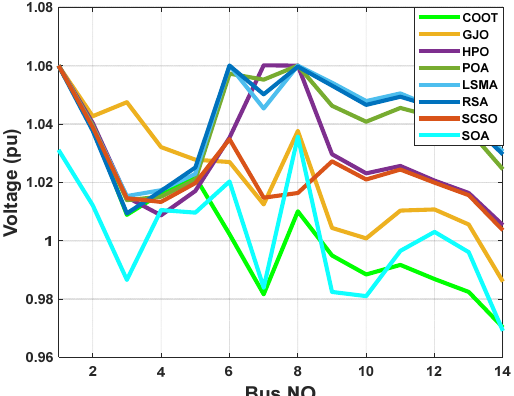
Figure 4. The voltage profile of the POA and other compared algorithms for case 1 in a standard IEEE 14-bus test system.